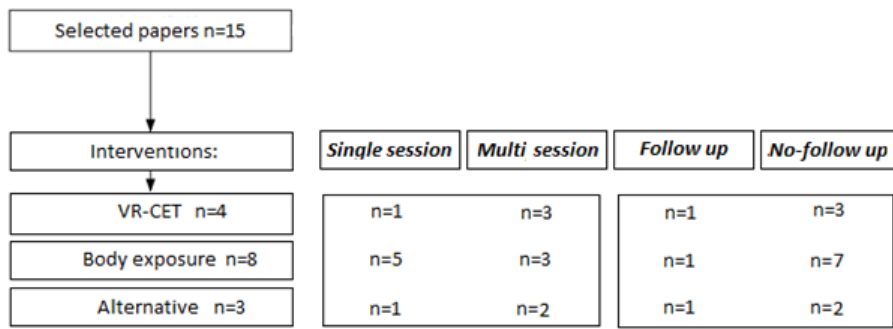
Figure 3. Overview of the included papers.